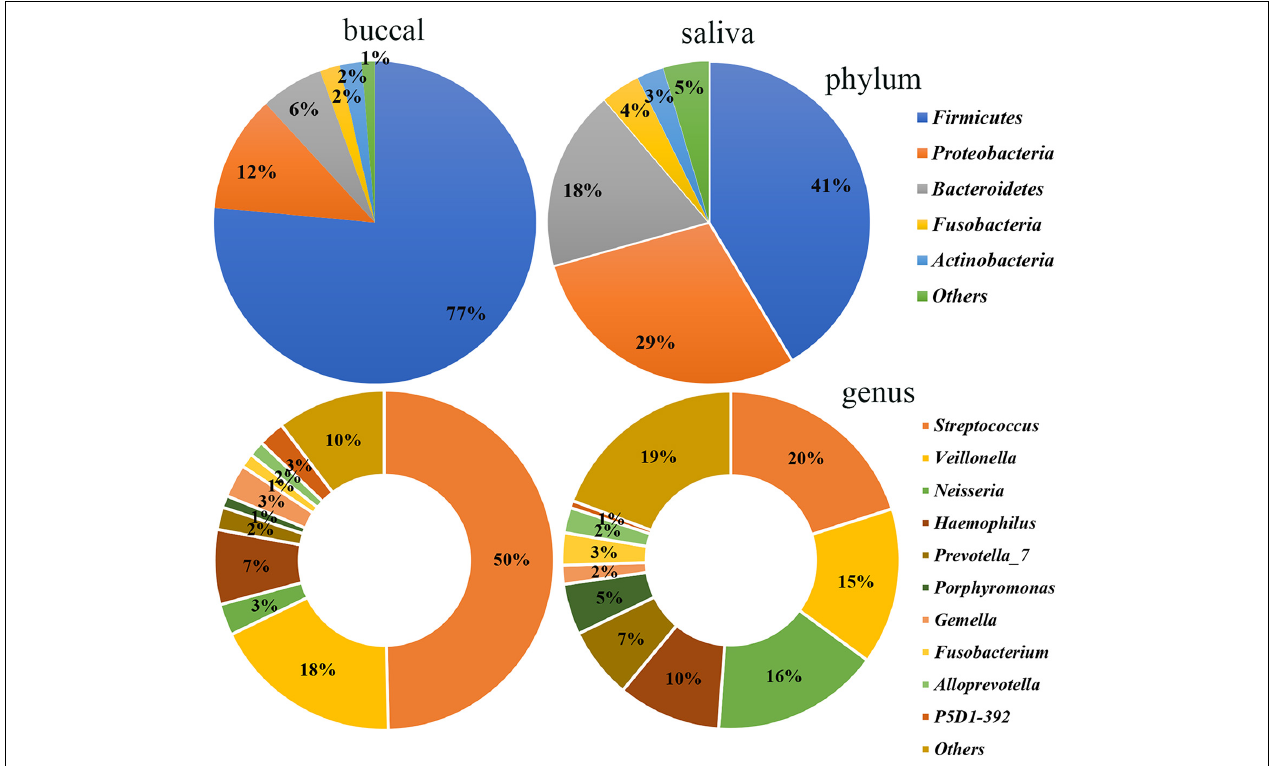
FIGURE 1 | Bacterial community composition of the saliva and buccal mucosa at the phylum and genus levels. At the phylum level, Firmicutes was the most abundant in the buccal mucosa and saliva. At the genus level, Streptococcus was the most abundant in the buccal mucosa while Streptococcus , Veillonella, and Neisseria had similar proportions in the saliva.